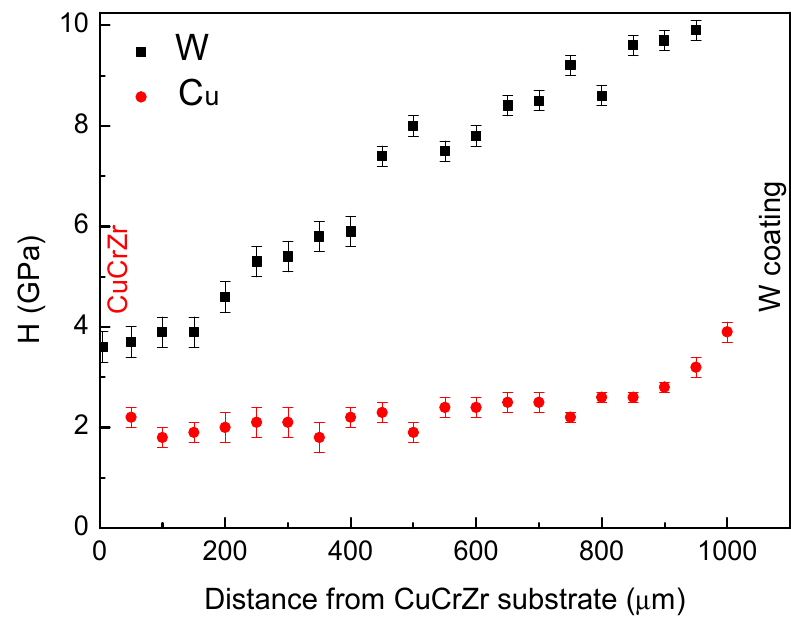
Figure 10. Hardness, H , trends of Cu and W across the interlayer.